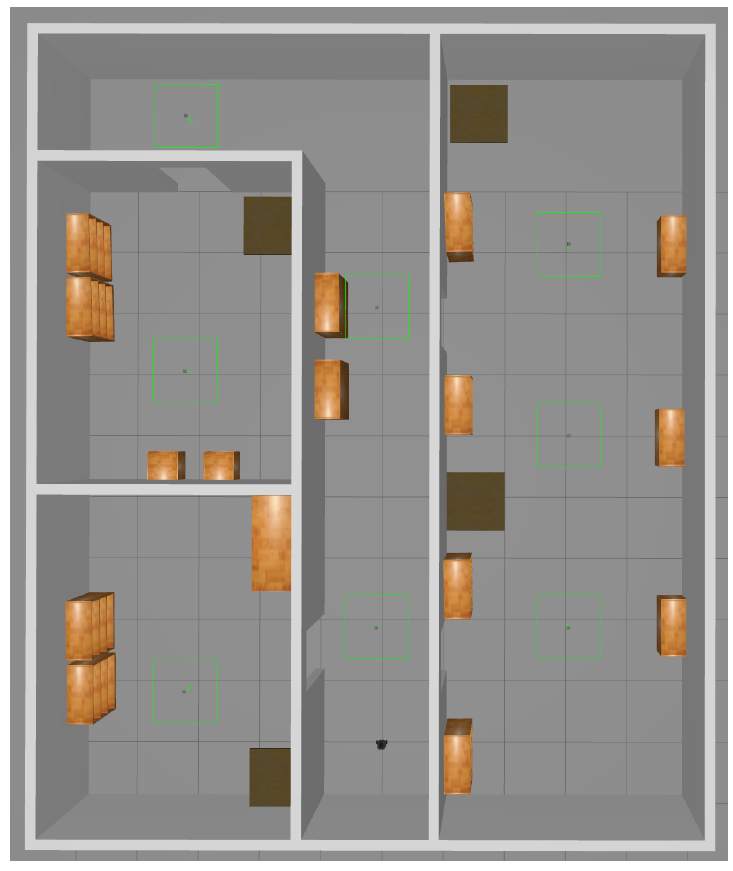
Figure 2. Simulation